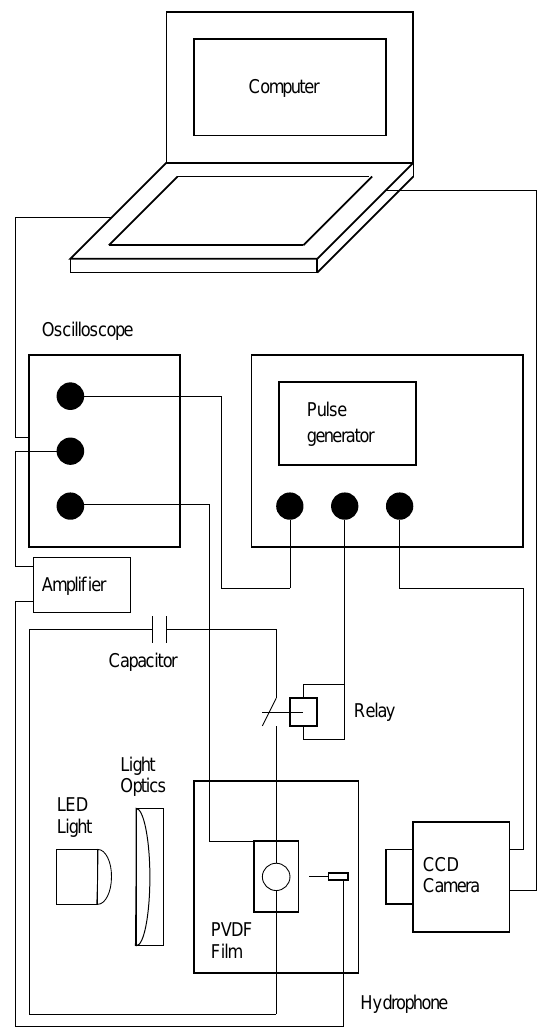
Fig. 2. Experimental setup used in the investigation of the cavitation bubble collapse.